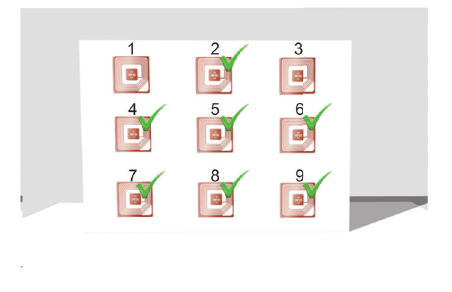
Figure 13: An example on tags